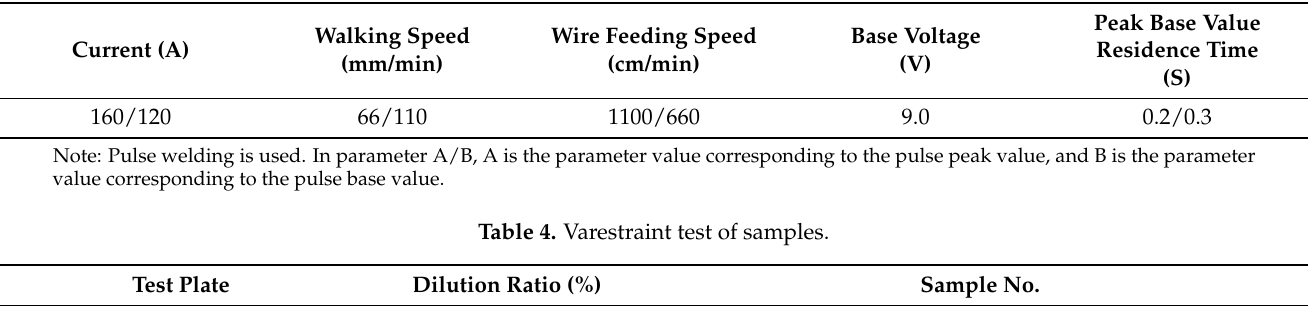
Table 4. Varestraint test of samples.